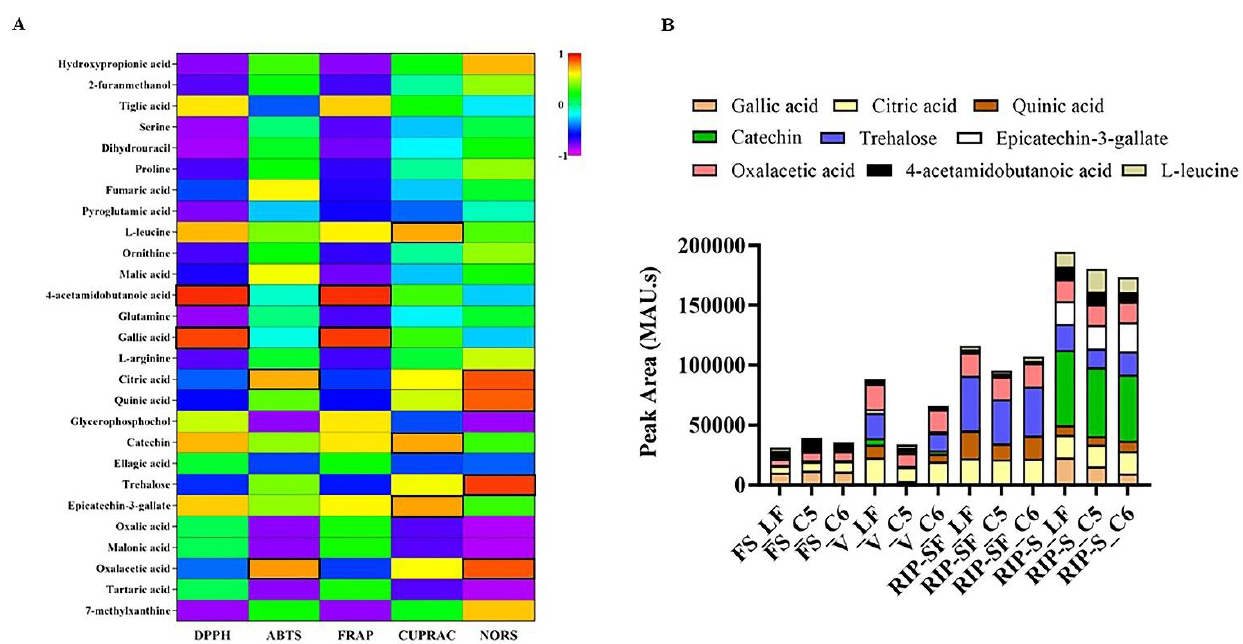
Figure 7. Pearson correlations ( A , B ) the intensity of absorbance (MAU.s) values of nutritional biomarkers of muscadine genotypes at selected developmental stages. FS_LF: fruit-set_Late Fry; FS_C5: fruit-set_C5-9-1; FS_C6: fruit-set_C6-10-1; V_LF: veraison_Late Fry; V_C5: veraison_C5-9-1; V_C6: veraison_C6-10-1; RIP-SF_LF: ripening-skin/flesh_Late Fry; RIP-SF_C5: ripening-skin/flesh_C5-9-1; RIP-SF_C6: ripening-skin/flesh_C6-10-1; RIP-S_LF: ripening-seeds_Late Fry; RIP-S_C5: ripening-seeds_C5-9-1; RIP-S_C6: ripening-seeds_C6-10-1.